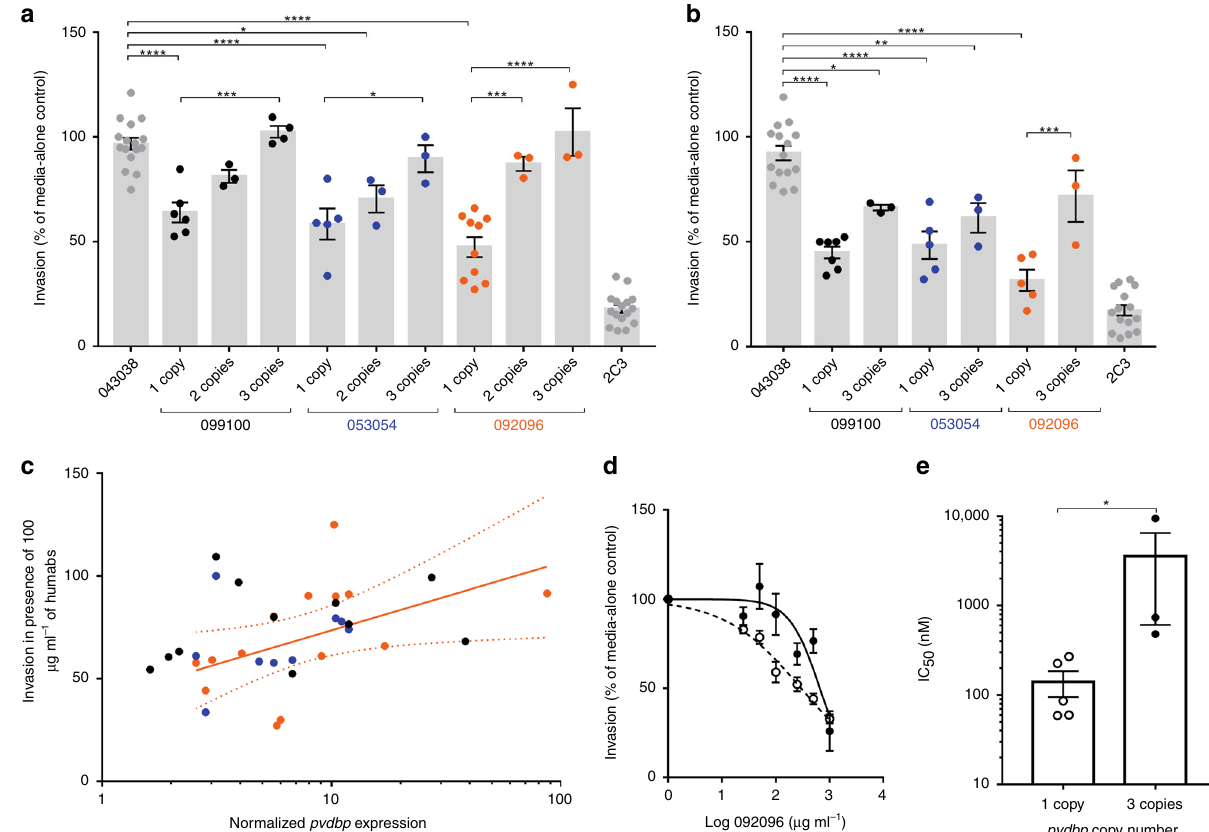
Fig. 2 Increased PvDBP gene copy number protects Pv against in vitro reticulocytes ’ invasion inhibition activity of human monoclonal anti-PvDBP antibodies. a Invasion by parasites with 1, 2 or 3 copies of pvdbp in presence of 100 μ g ml − 1 of the humabs 099100, 053054 and 092096 is normalized to media-alone controls. Negative control is made of the isotype-matched humab 043038 and the positive control is made of the anti-Duffy monoclonal antibody 2C3. Each dot represents the average inhibition of a single clinical isolate ( n = 3 to 10 different isolates per condition, 1 to 3 technical replicates per isolate). Mean ± SEM. Differences are assessed by ANOVA (F(10, 61) = 51.51, P < 0.0001) and Tukey ’ s post-hoc tests (* P < 0.05, *** P < 0.0005, **** P < 0.0001). b Reticulocyte invasion by parasites with 1 or 3 copies of pvdbp in presence of 500 μ g ml − 1 of humabs. Each dot represents the average inhibition of a single clinical isolate ( n = 3 to 7). Mean ± SEM. Differences are assessed by ANOVA (F(7, 48) = 47.36, P < 0.0001) and Tukey ’ s post-hoc